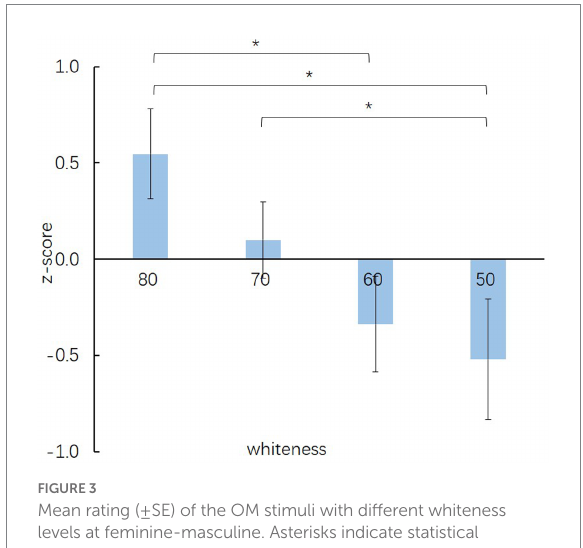
FIGURE 3 Mean rating (±SE) of the OM stimuli with different whiteness levels at feminine-masculine. Asterisks indicate statistical significance at * p < 0.05 (Games-Howell corrected).